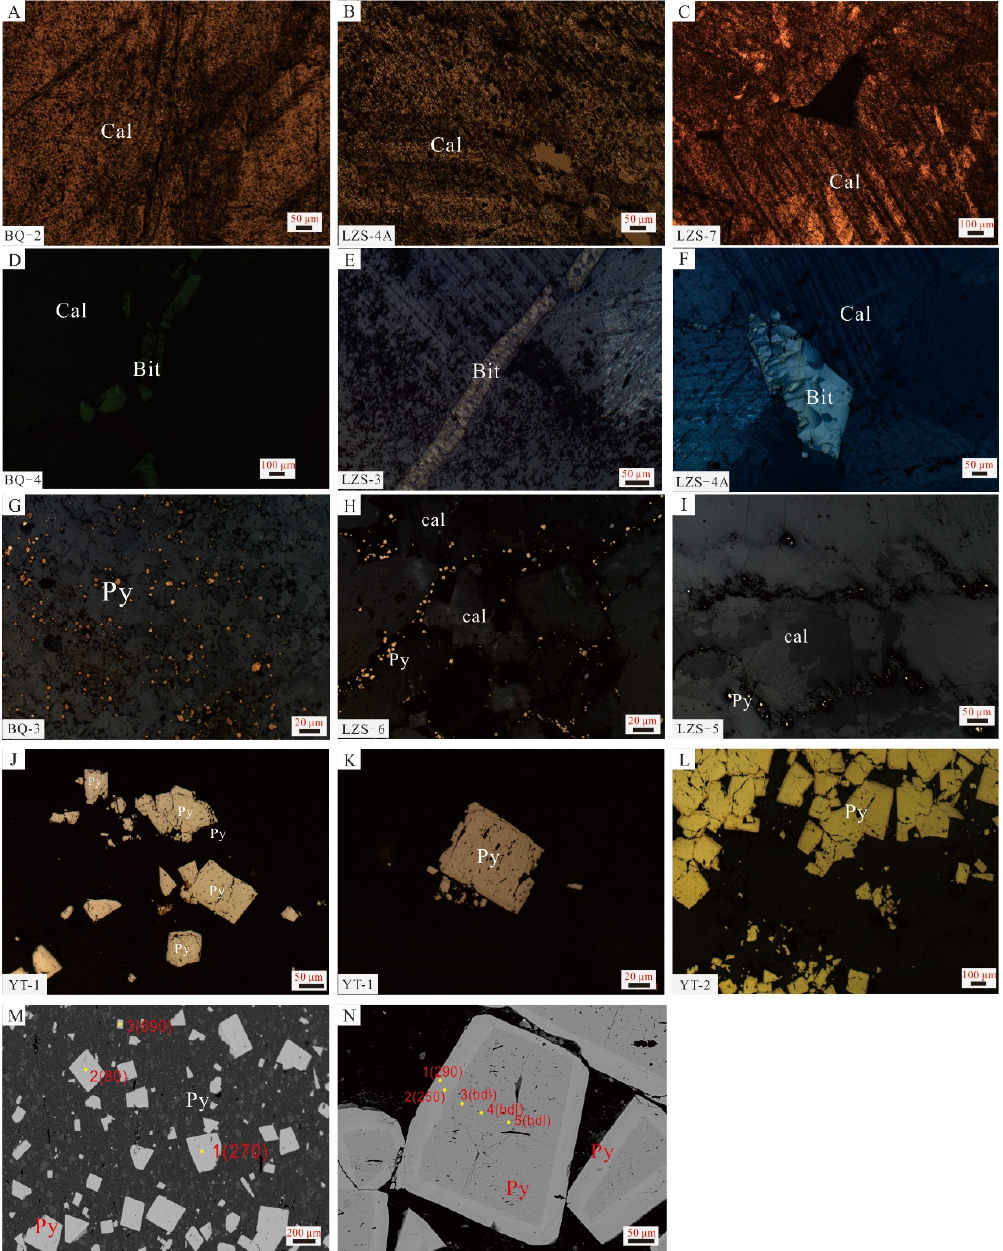
Figure 5. Photographs showing the characteristic of white calcite of the Banqi-Yata-Laizishan area. ( A – C ) buck calcite, with fuzzy cleavage texture and poor continuity. ( D – F ) Mosaic bitumen within the white calcite. ( G – I ) Fine-grained pyrite distributed within calcite pores and fissures from the Banqi-Laizishan area. ( J – L ) Banded pyrite with core-rim structure from the Yata area. ( M , N ) Backscattered electron imaging and Electron probe microanalysis (EPMA) of pyrite from No. 940 mine in the Yata gold deposit [32]).